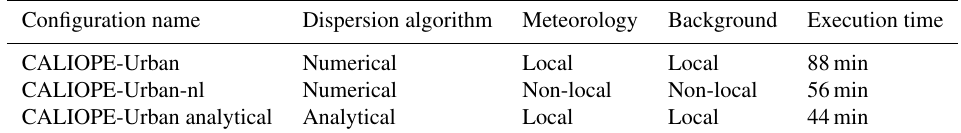
Table 2. Description of the execution setup. Execution time is for the entire city of Barcelona during 1h running CALIOPE-Urban (i.e. only the urban system, after CALIOPE run completion) over 11251 street segments and 965458 receptors at 10m × 10m spatial resolution.